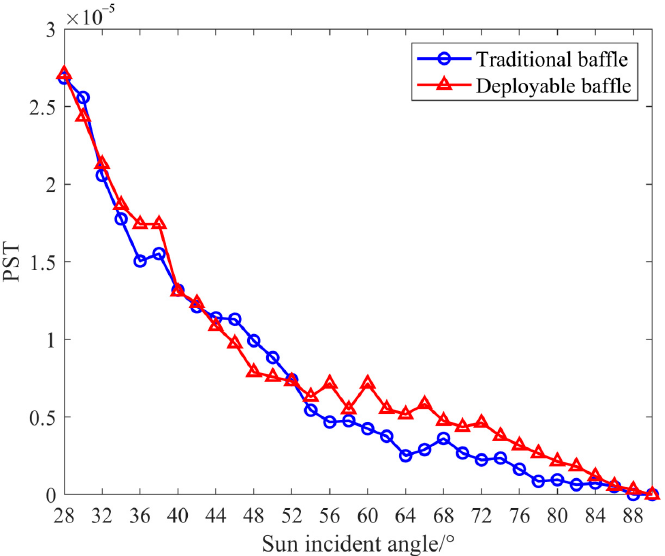
Figure 15. PST comparison between two type baffles with 28~90° sun angle (interval of